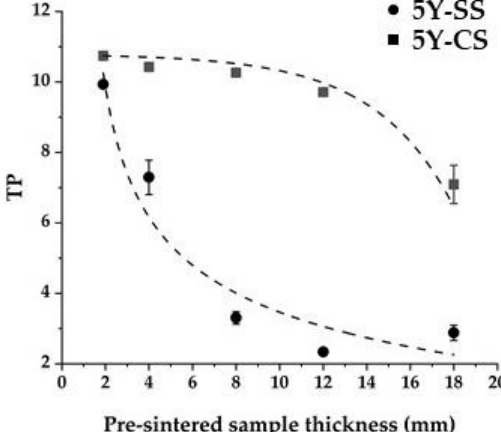
Figure 11. Relationship between the specimen ’s pre-sintered thickness and TP.